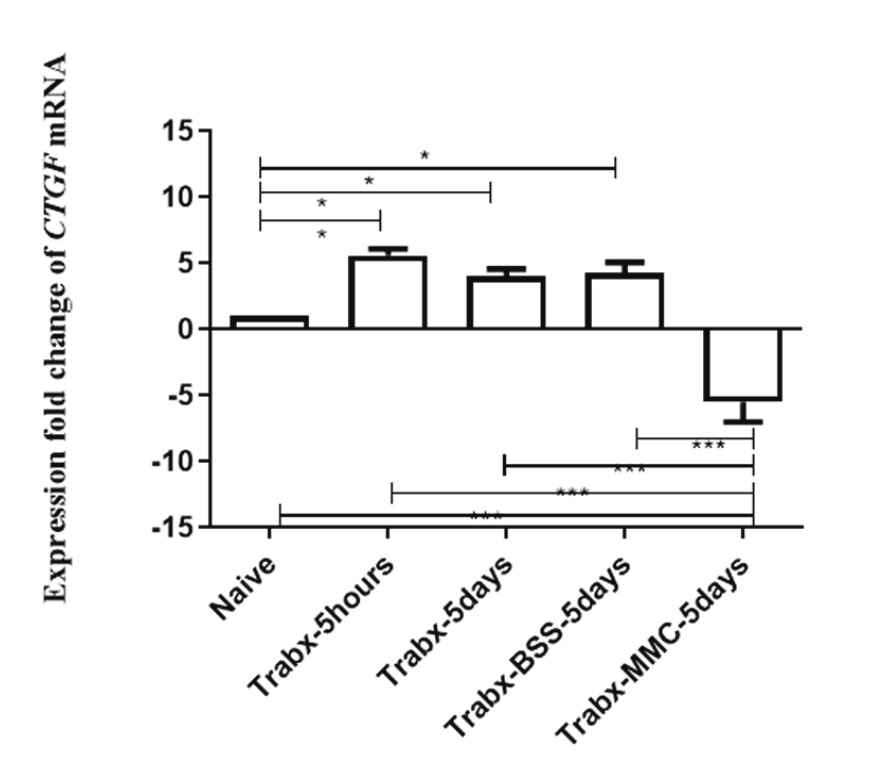
Figure 5. Expression fold change of CTGF mRNA. The effect of each treatment is reported as fold change with respect to control eyes. Significance at < 0.05, < 0.01, and < 0.001 are indicated in figures by *, **, and ***, respectively.